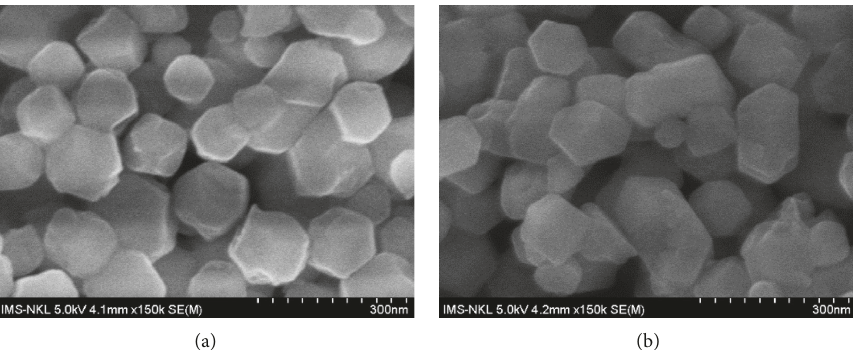
Figure 6: SEM images of ZIF-8 crystals synthesized with process A as a function of synthesis time: (a) two days; (b) five days.